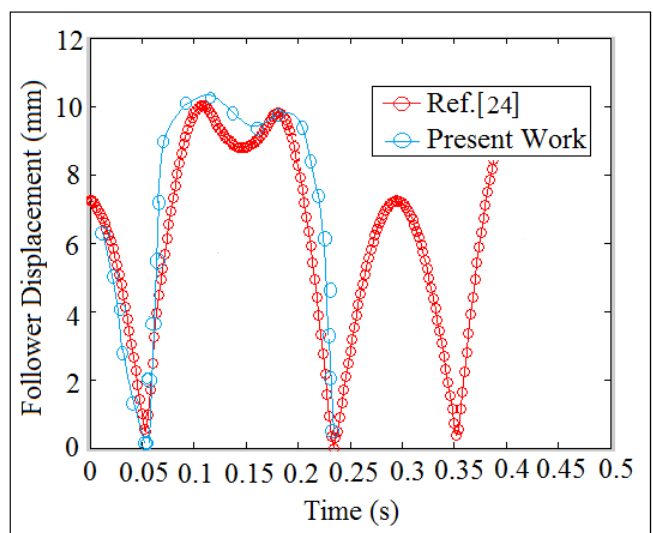
Figure 13. Comparison of nonlinear response of the follower.